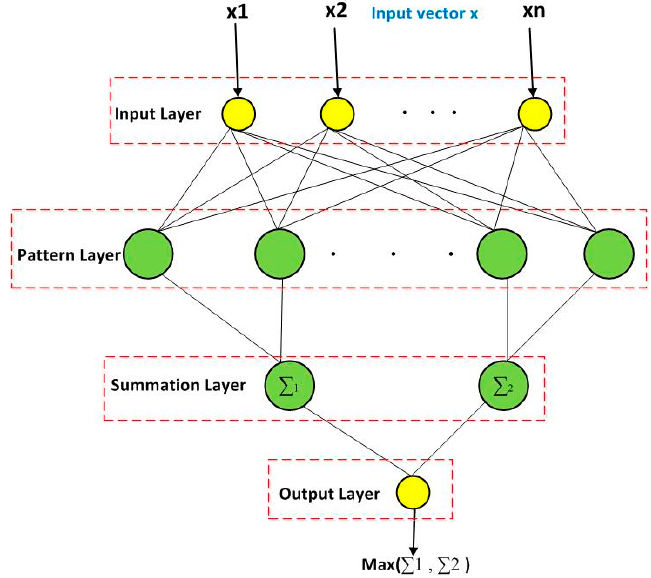
Figure 3. General diagram for the Probabilistic Neural network (PNN).